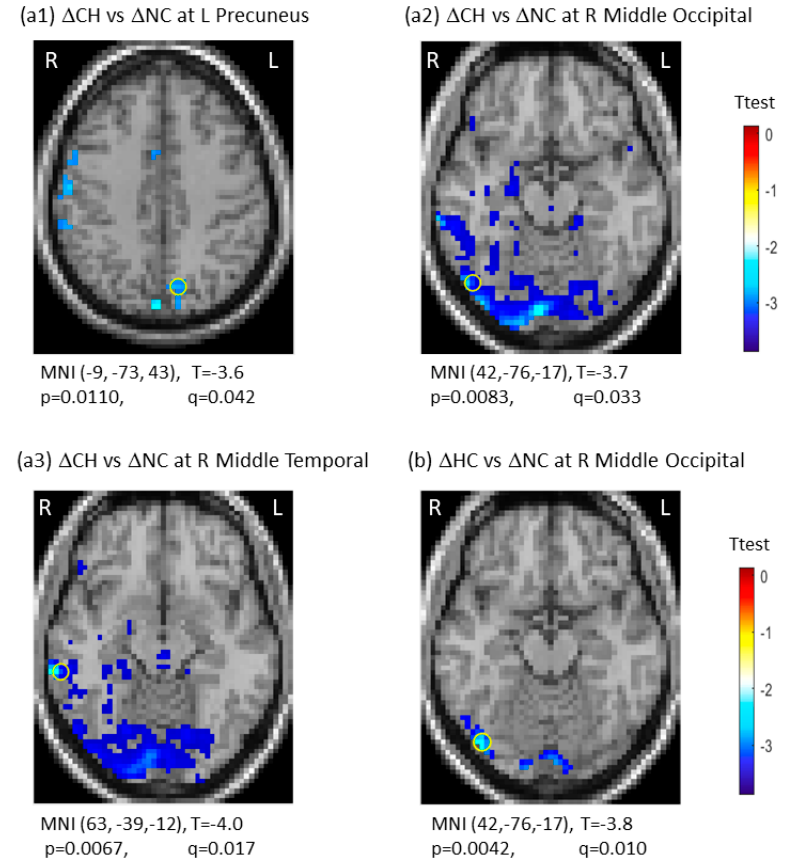
Figure 2. Significant group-by-time interactions of longitudinal changes in blood-oxygen-level- dependent (BOLD) signal variability in standard deviation ( ∆ SD BOLD ) between the chemotherapy group (CH) and the no-chemotherapy group (NC) ( a1 – a3 ), and between the healthy control group (HC) and the no-chemotherapy group (NC) ( b ). The most significant regions were marked with “o”. CH: Chemotherapy group; FDR: false discovery rate; HC: healthy control group; L: left side; NC: No-chemotherapy group; q = p FDR after multiple comparison, R: right side, Δ : longitudinal change.